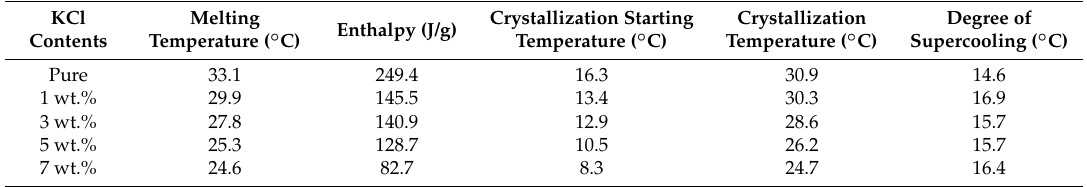
Table 2. Thermal properties of the Na 2 SO 4 · 10H 2 O–KCl eutectic mixtures with varying contents of